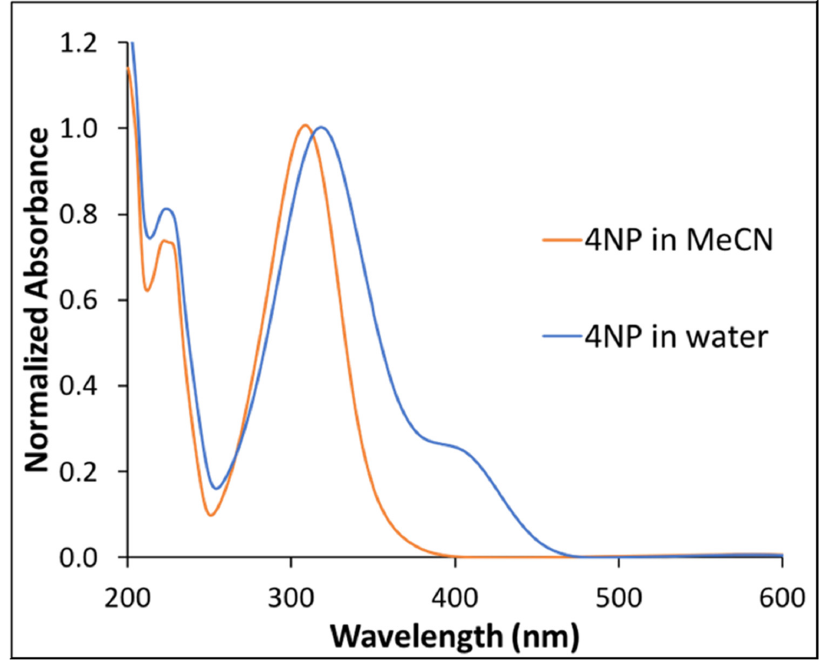
Figure 2. Normalized absorption spectra of 4NP in water and in MeCN. The absorption spectra for four other nitroaromatics and phenol in two different sol- vents (water and MeCN) are presented in Figure S3 of Supporting Information. Similar to 4NP, a slight bathochromic shift was observed for other nitroaromatics in water. No sig- nificant changes in the shape of the absorption spectra for other nitroaromatics were ob- served in protic and aprotic solvents. In contrast to 4NP, no additional peak was observed in other nitroaromatics due to hydrogen bonding. Since all nitroaromatics are nonfluores- cent molecules, no fluorescence emission results are presented for these nitroaromatics.